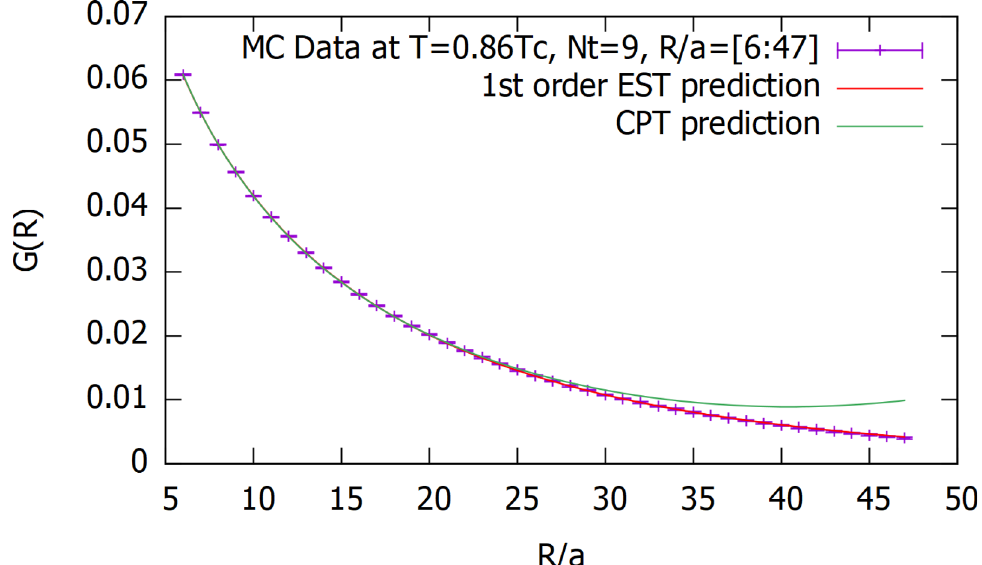
= 0 . 86 combining both the short- c